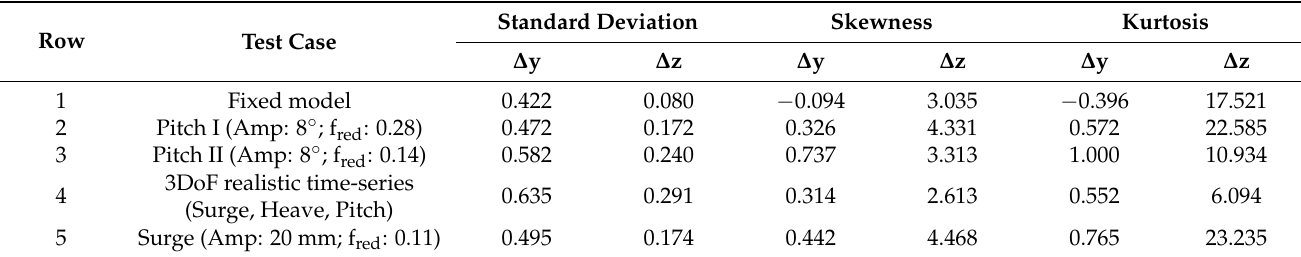
Table 2. Statistics of wake centre time